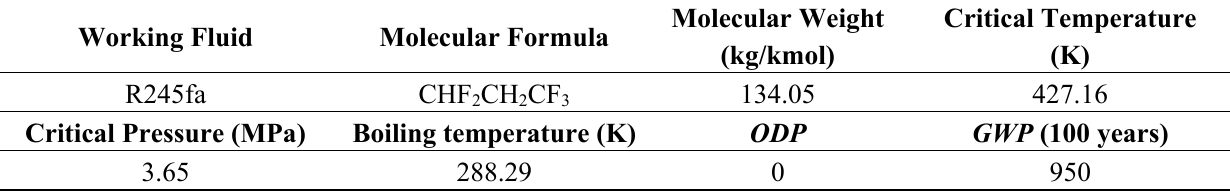
Table 1. Main properties of working fluid R245fa.